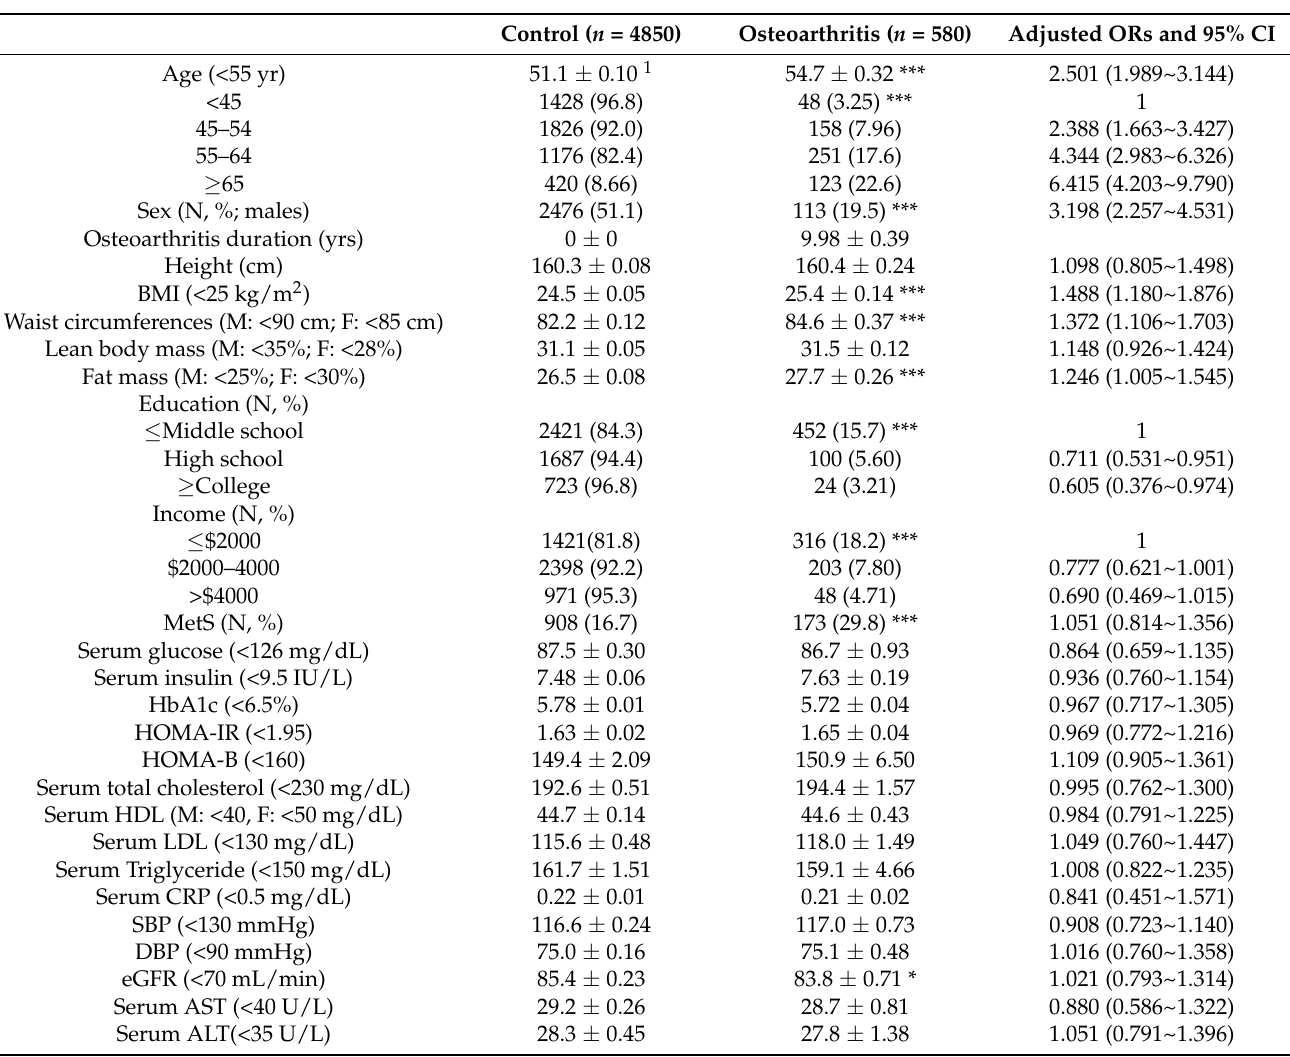
Table 1. Characteristics of the participants with